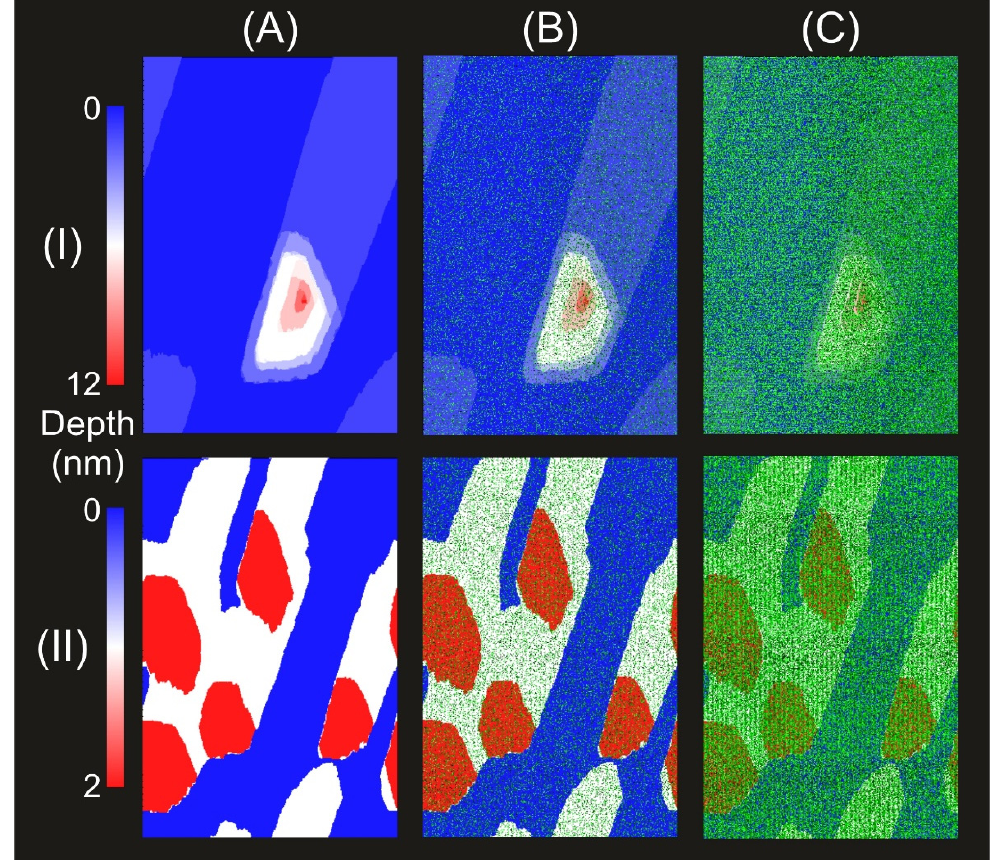
Figure 2. Case ( I ) with a single deep etch pit (d = 12 nm) and case ( II ) with six etch pits randomly distributed over the surface, each with a depth of 2 nm. Column ( A ) shows the muscovite surface after the dissolution of 2 million atoms. In columns ( B ) and ( C ) adsorbed radionuclide atoms are marked with green dots. Row ( B ) shows an intermediate stage of adsorption after 75.000 adsorbed atoms. Row ( C ) shows the final surface configuration after 300.000 adsorbed atoms. No pattern of radionuclide adsorption is visible as the distribution appears to be random.